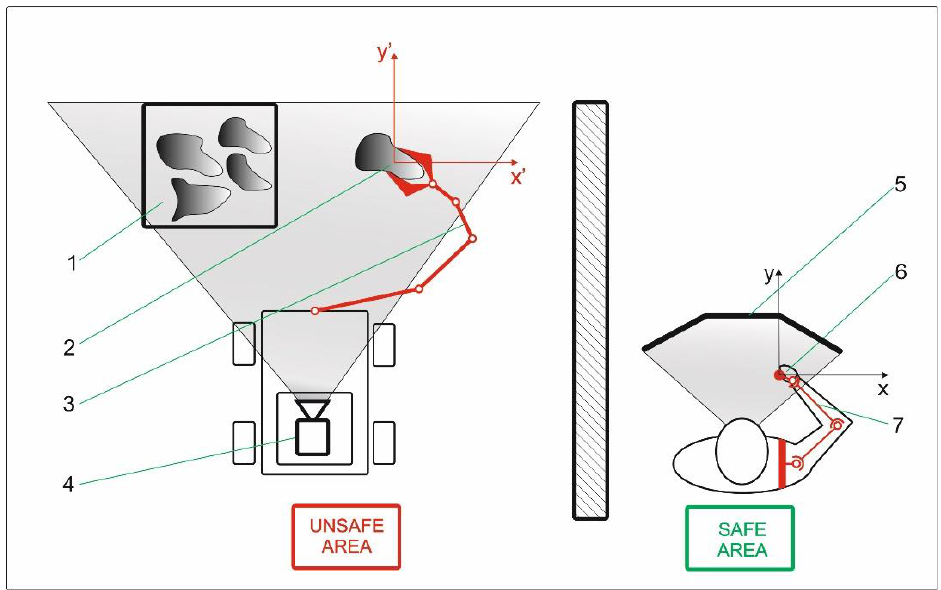
Figure 1. Idea of using master-slave system in intervention operation: 1 — removed objects, 2 — picked object, 3 — manipulator; 4 — cameras; 5 — displays; 6 — hand; 7 — human arm.